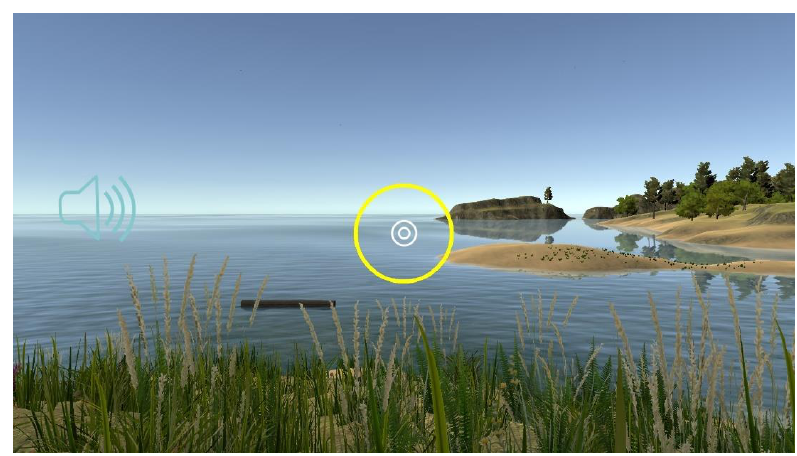
Figure 3. The interaction sign is represented by the white double circle.